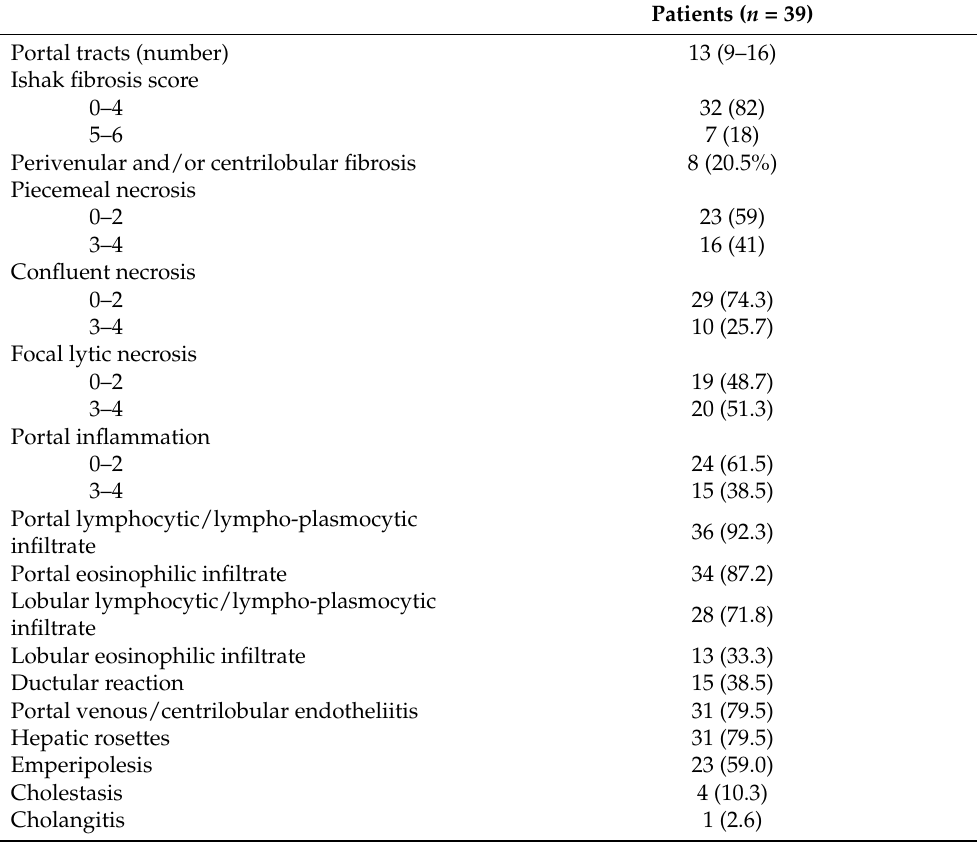
Table 2. Histologic characteristics of liver biopsies performed in patients at disease presentation. Categorical variables are reported as frequencies (%), and continuous variables are reported as medians (interquartile